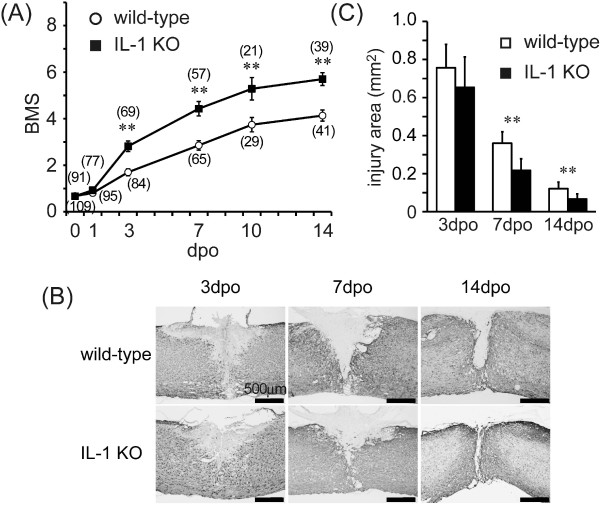
SCI was suppressed more in IL-1 KO than in wild-type mice. (A) Motor function determined according to the Basso Mouse Scale improved in a time-dependent manner after SCI in wild-type (open circles) and IL-1 KO mice (closed squares). The score for IL-1 KO mice is significantly improved compared to the wild-type from the 3rd dpo. Numbers in parentheses indicate sample numbers at each time point. Data are expressed as mean ± SE. **: P <0.01 (Student's t-test). (B) Representative images of GFAP-immunostaining after SCI. The injured area as defined by GFAP-positive cells is relatively smaller in IL-1 KO mice than in the wild-type. (C) The injured area is significantly suppressed in IL-1 KO mice (n = 5 to 7, filled bars) at the 7th and the 14th dpo compared to wild-type (n = 7 to 10, open column). Data are expressed as mean ± SE. **: P <0.01 (Student's t-test). dpo, days post-operatively; GFAP, glial fibrillary acidic protein; SCI, spinal cord injury.